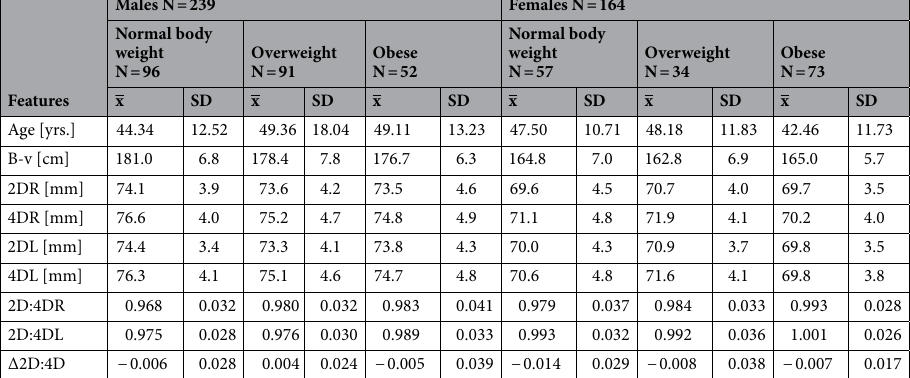
Table 1. Mean age, anthropometric measures, 2D:4D ratios and Δ2D:4D of study participants. x , mean; SD, standard deviation; B-v, body height; 2D, second finger length; 4D, fourth finger length; 2D:4D, second to fourth digit ratio; R, right hand; L, left hand; Δ2D:4D = 2D:4DR -2D:4DL.